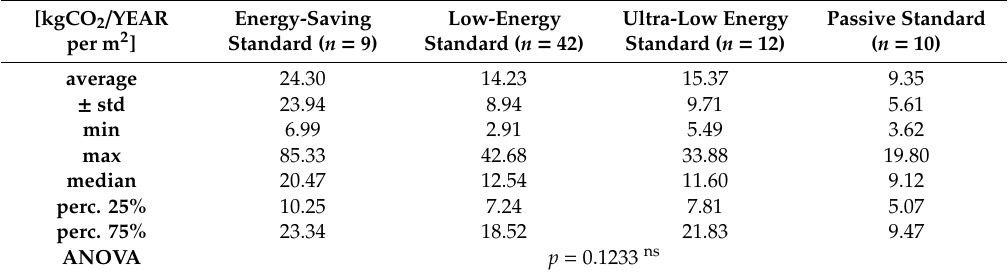
Table 3. Annual CO 2 production in relation to heating categorized according to energy standards calculated per m 2 of useful floor area of the analyzed wood constructions regardless of the construction